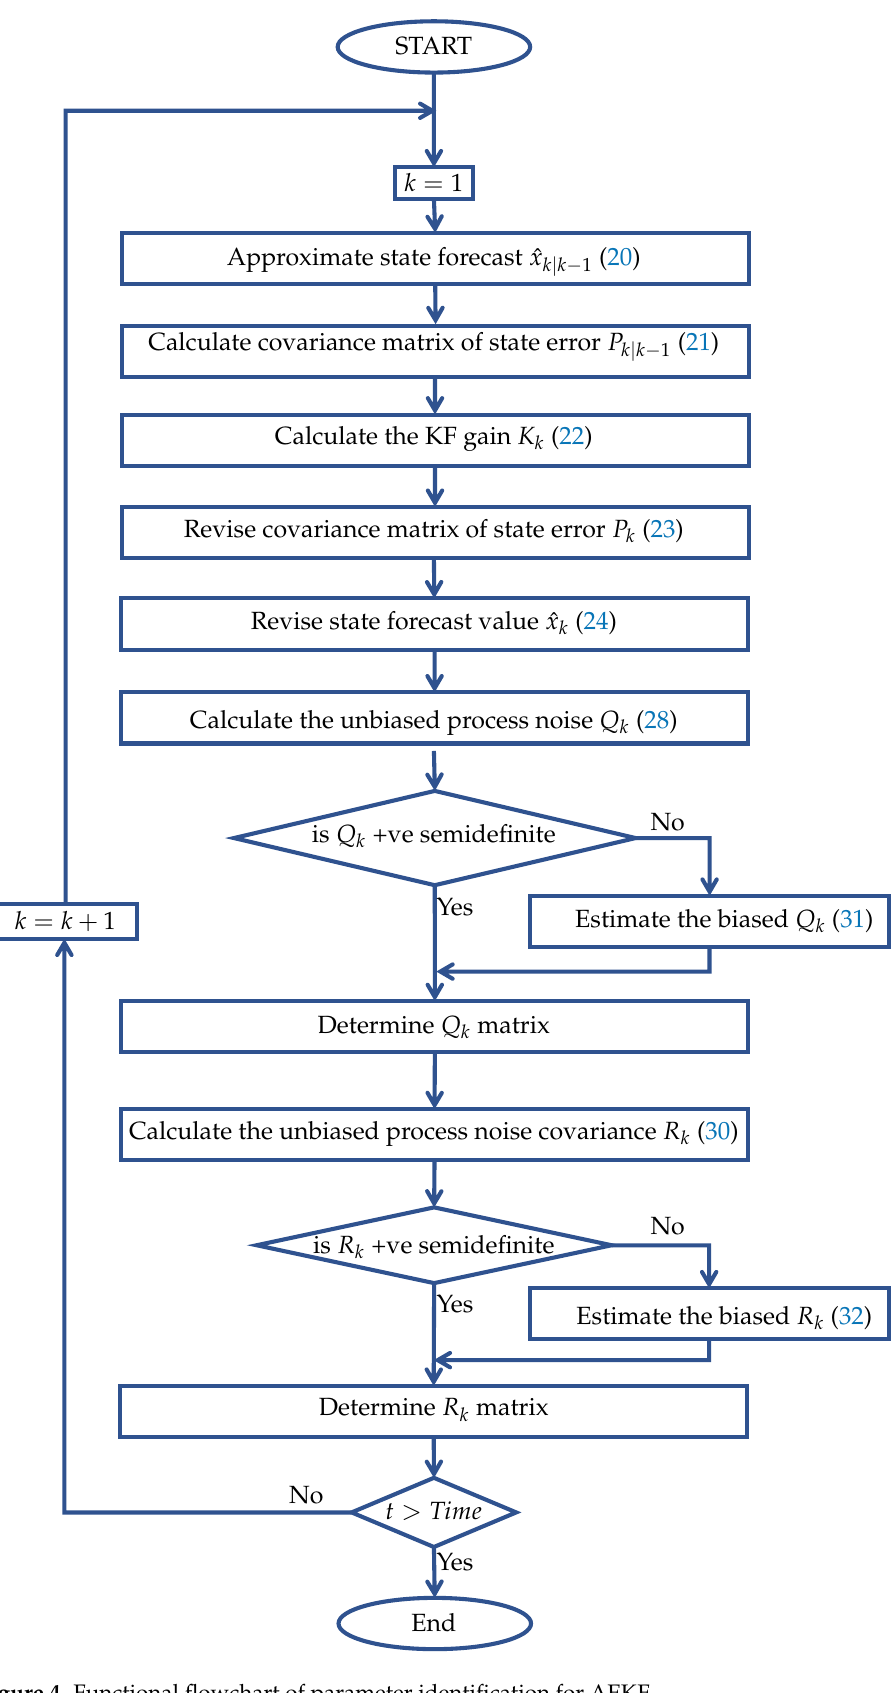
Figure 4. Functional flowchart of parameter identification for